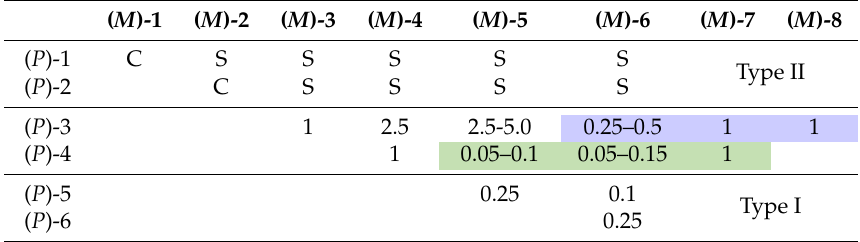
Figure 19. Self-assembly gel formed by a hetero-double-helix ( a ) shown by CD spectra ( b ) and TEM image ( c ). Reproduced from reference 71 by permission from John Wiley & Sons. Table 1. Two-component gels formation by the pseudo-enantiomeric ethynylhelicene oligomers shown by minimal gelation concentrations (mM). The compounds are shown in terms of the absolute configuration and numbers of helicene. The types of the gels formed by the combinations, type I and II, are also shown by shades in green and blue,